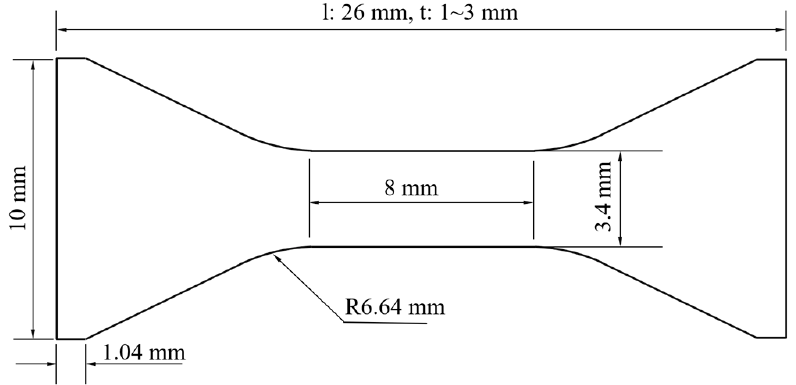
Figure 1. The dimensions of mechanical property test samples.